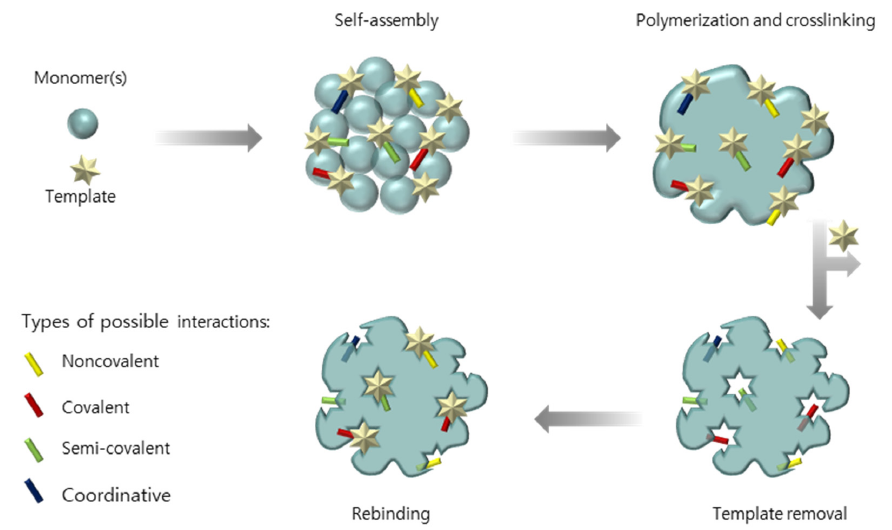
Figure 1. Synthetic steps to prepare